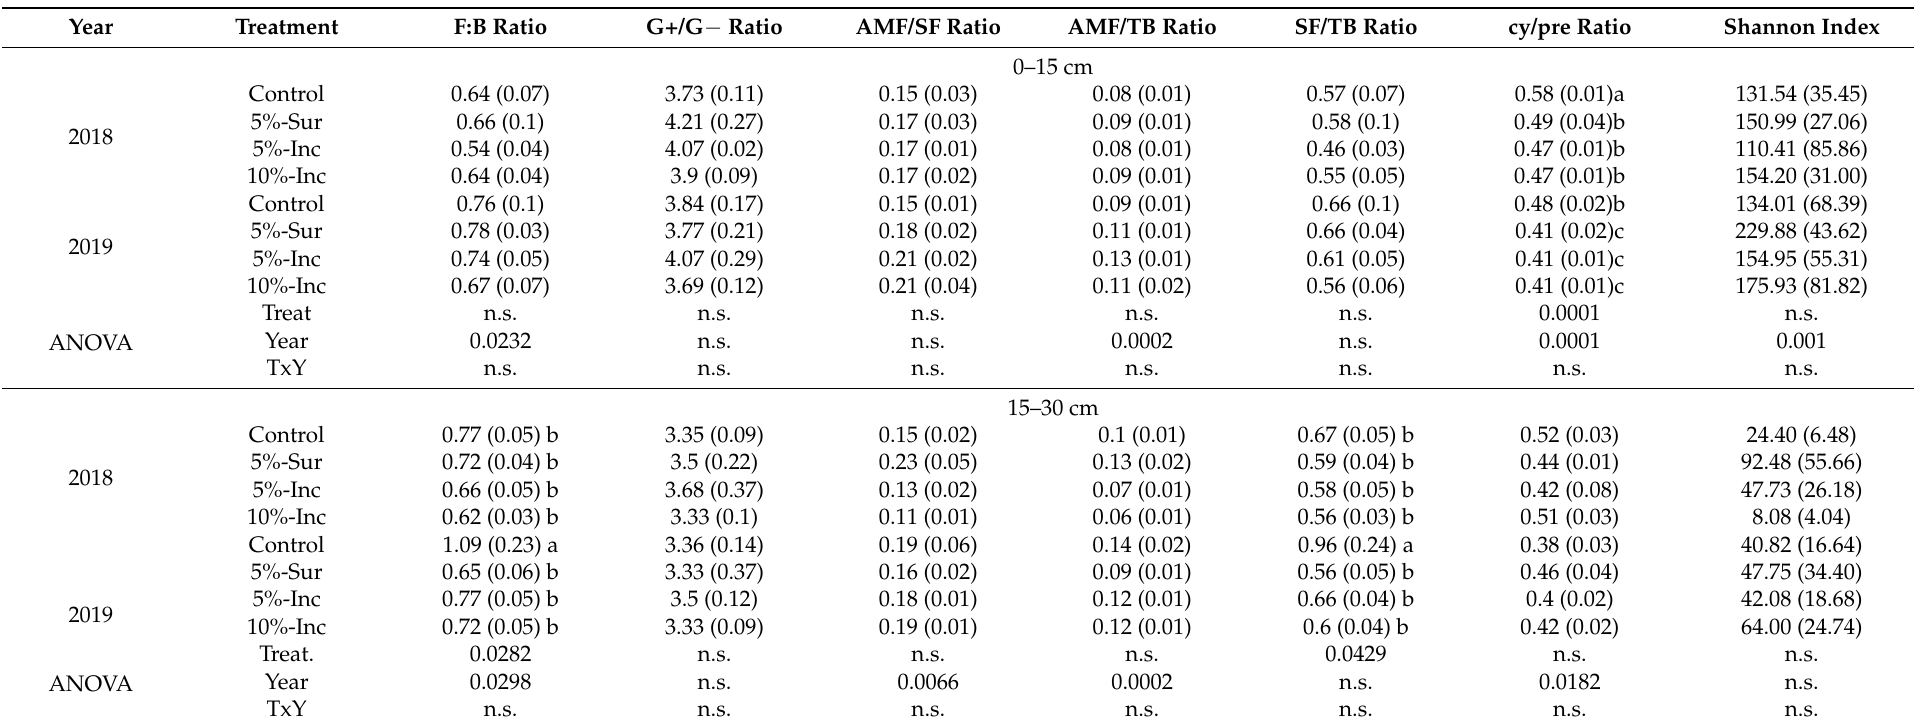
Table 2. Ratios between FAME groups with and without biochar addition. Numbers in bracket represent standard error of the means ( n = 6). Inc-incorporated; Sur-surface. F:B-fungal to total bacterial FAME; G+/G–Gram-positive to Gram-negative bacterial FAME; AMF/SF-Arbuscular mycorrhiza fungi to saprophytic fungi FAME; AMF/TB-Arbuscular mycorrhiza fungi to total bacteria FAME; SF/TB-saprophytic fungi to total bacteria FAME; and cy/pre-cyclopropyl to precursor FAME; n.s.-non-significant ( p -value > 0.05). The letter indicates statistical significance differences based on the LSD Fisher test with a p -value <